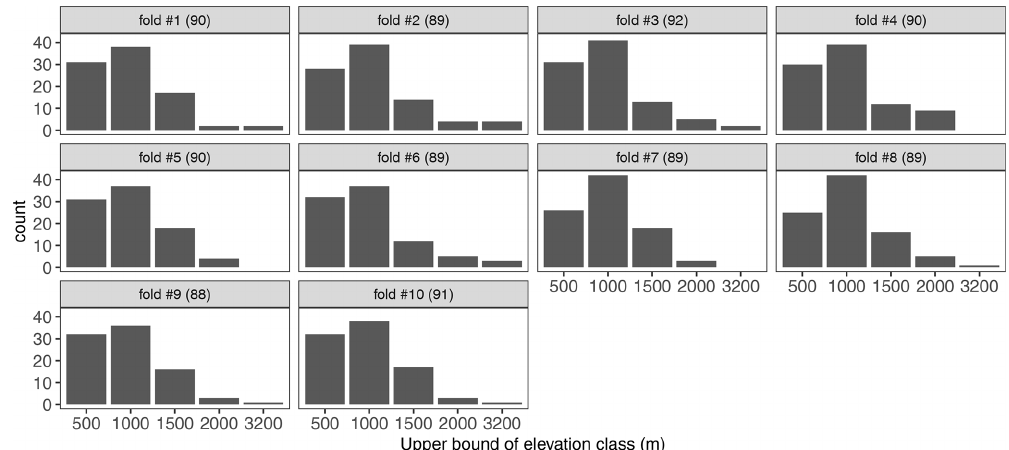
Figure A1. Elevation histograms of the 10 randomly found subsets of all 897 stations. Respective number of members is given in brackets.